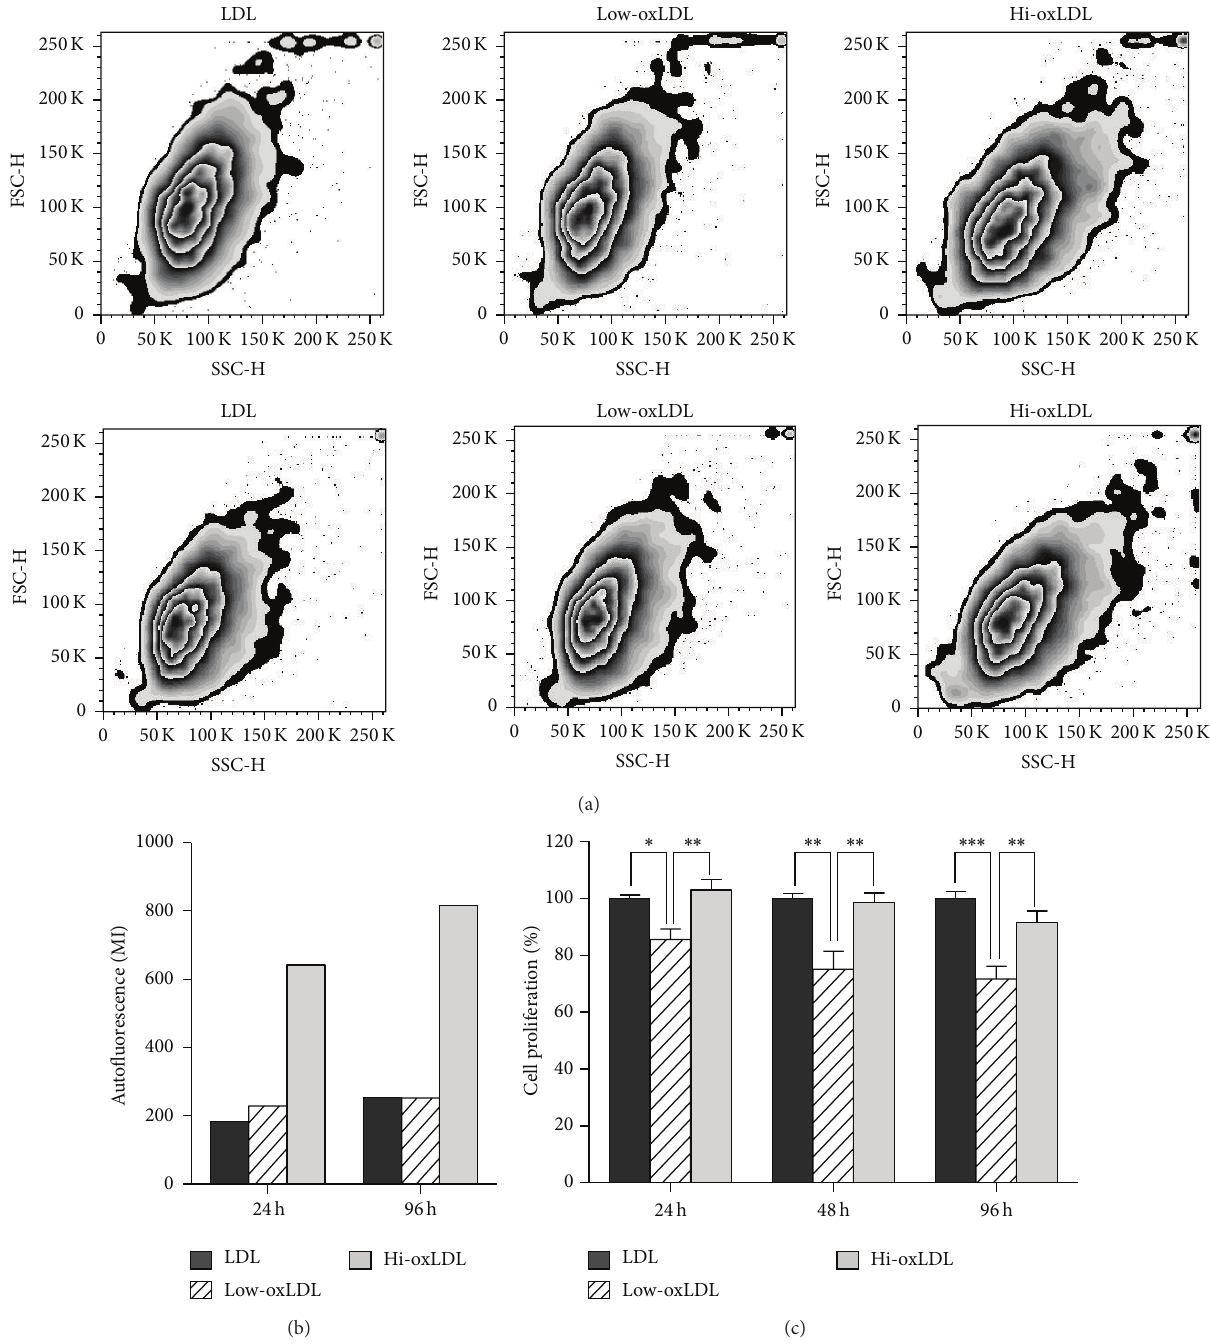
Figure 1: Effects of oxLDL on granularity, autofluorescence, and proliferation. THP-1 cells were treated with differentially oxidized LDL (50 𝜇 g/mL) for 24, 48, or 96 h. (a) Granularity and (b) autofluorescence were measured by flow cytometer. (c) Cell proliferation was assessed byCCK-8assay.Datarepresentmeans ± S.E.ofthreeindependentexperiments.One-wayANOVAanalysiswasusedtodeterminesignificance ( ∗ 𝑝 < 0.05 , ∗∗ 𝑝 < 0.01 , and ∗∗∗ 𝑝 < 0.001 ).